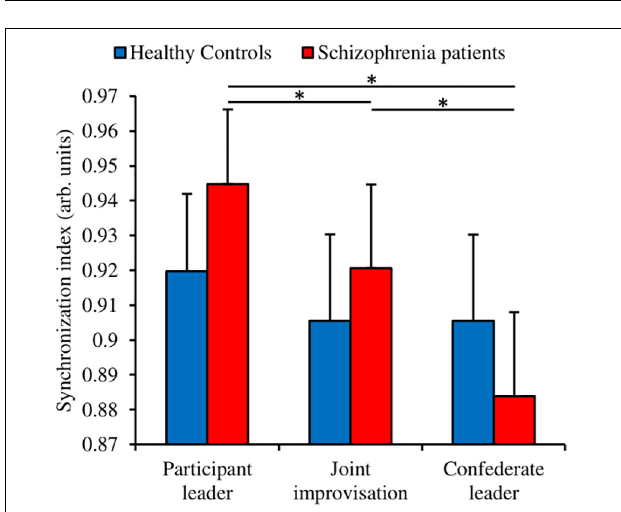
FIGURE 2 | Socio-motor improvisation extracted from the participants motion. Error bars correspond to the standard deviation around the mean. Star indicates significant post hoc differences.